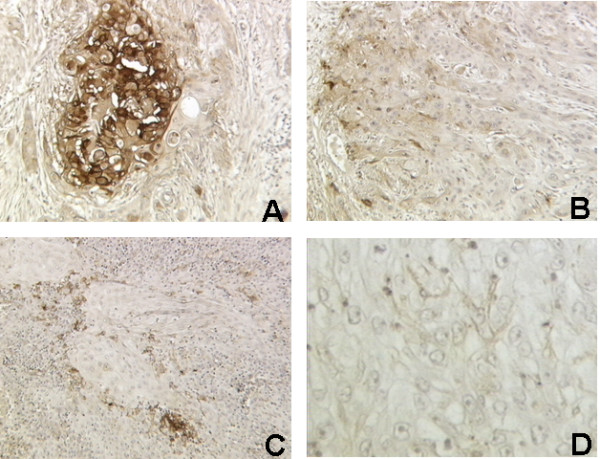
uPAR expression in OSCC. A: Strong cytoplasmic positivity of neoplastic epithelial cells in poorly differentiated OSCC (G3) (× 250). B: Weak cytoplasmic positivity of epithelial cells of invasive front in moderately differentiated OSCC (G2) (× 200). C: Focal strong positivity in stromal and inflammatory peritumoral cells in moderately differentiated OSCC (G2) (× 160). D: Negativity of an adjacent section incubated with an isotype-matched monoclonal control antibody (× 400).